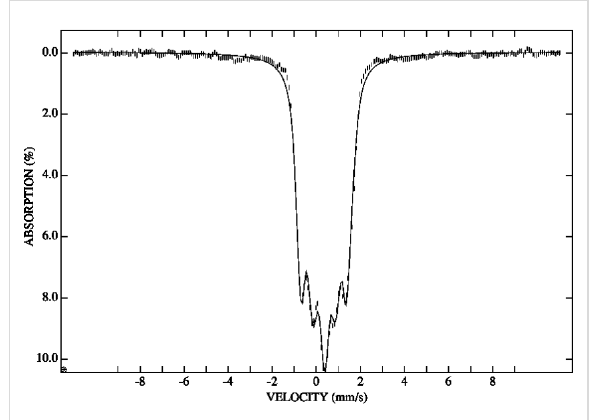
Figure 4: 3 K Mössbauer spectrum of polycrystalline 2 recorded in a perpendicularly applied field of 5.0 T. The solid line is a spectral simu- lation for Δ E Q = 0.80 mm/s, δ = 0.47 mm/s, and η = 0.95, assuming an isolated ground state with S = 0 for a dinuclear Fe 2 cluster.